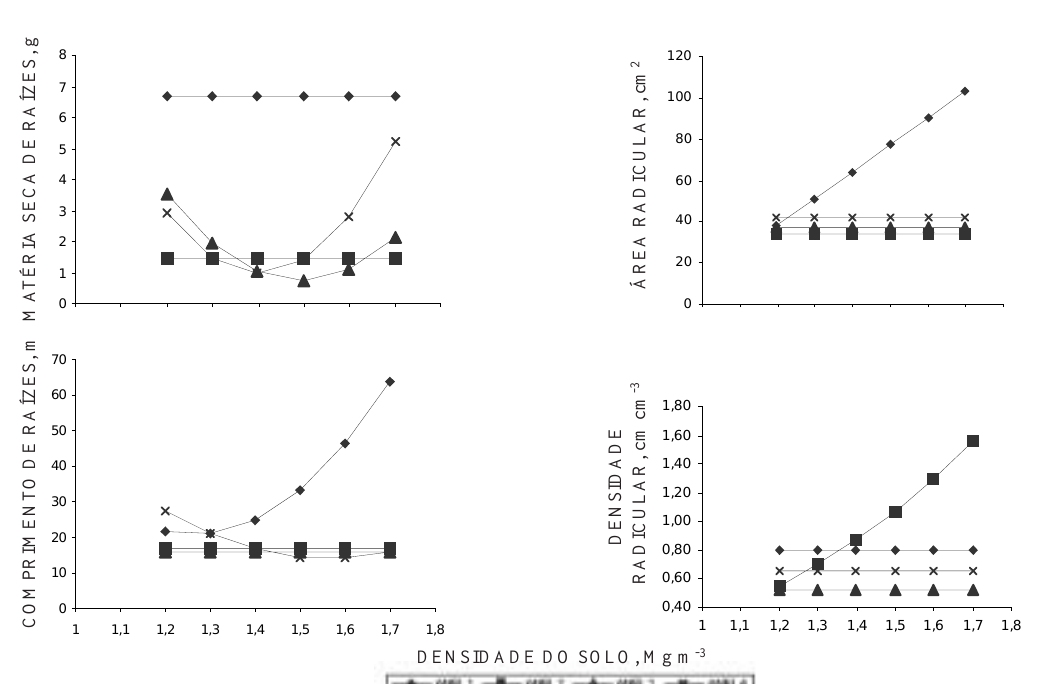
Figura 3. Matéria seca de raízes (MSR), área radicular (AR), comprimento de raízes (CR), densidade radicular (DR) de plantas de cajueiro cultivadas em colunas de solo, considerando diferentes níveis de densidade do